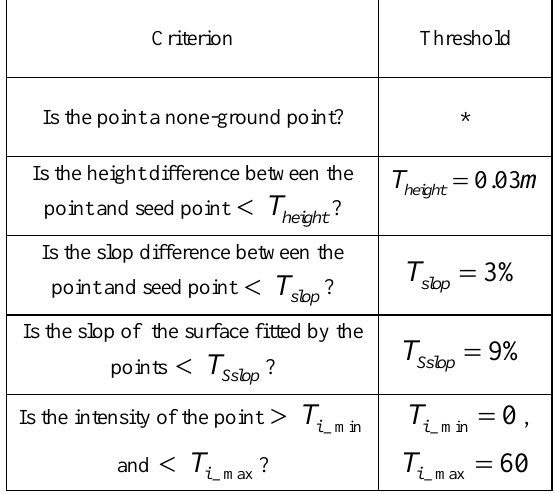
Table 1. Margin settings for A4 size paper